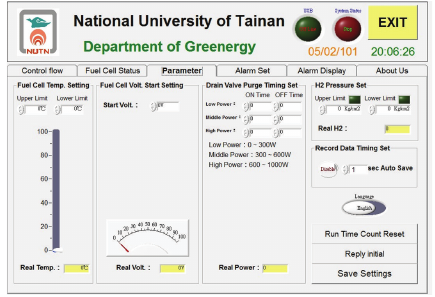
Figure 9: Input screen for critical system parameters.